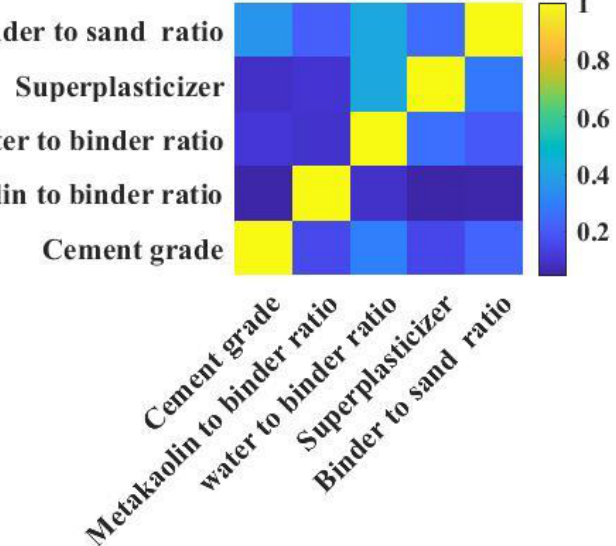
Figure 1. Correlation coefficients matrix diagram.